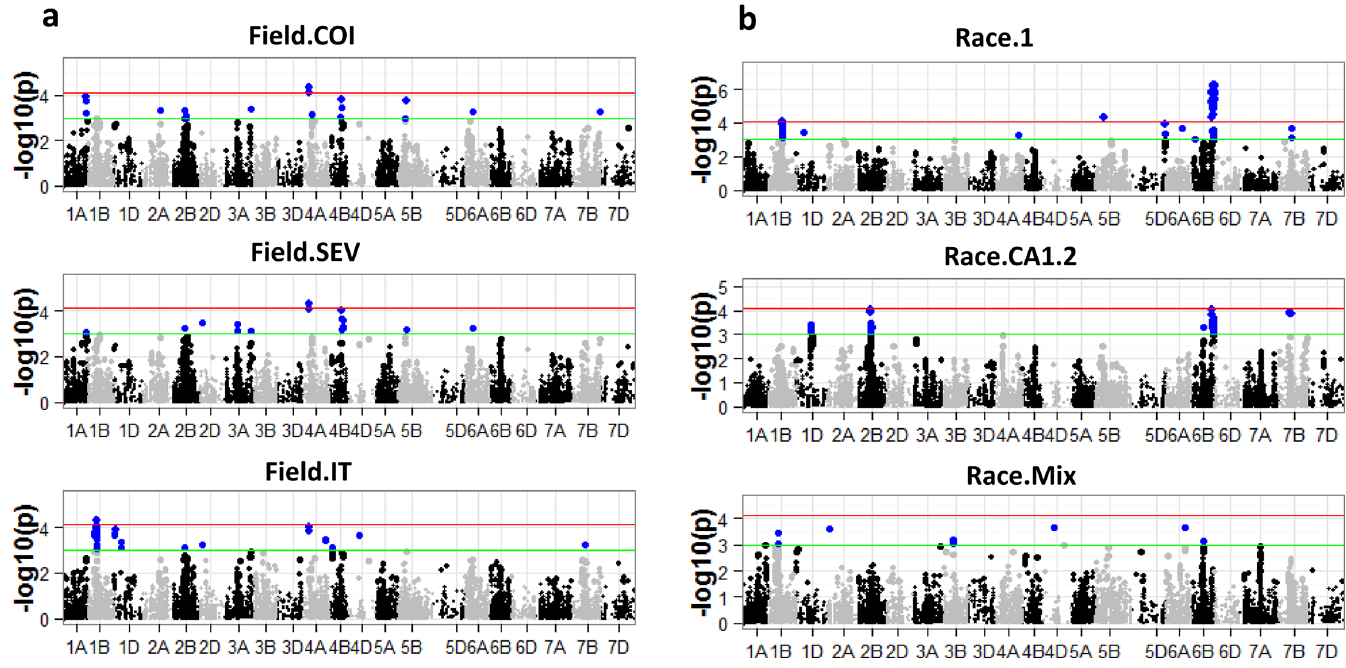
Fig 5. Manhattan plots for field (a) and seedling (b) traits. Red line indicates SimpleM bonferroni corrected p-value threshold for significance (7.7x10-5); Green line indicates p-value of 1x10-3.